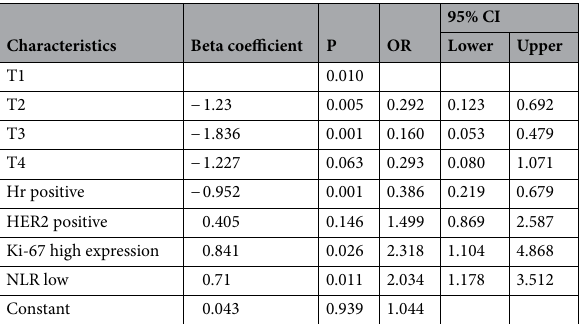
Table 3. The results of multivariate logistic regression analysis. HR hormone receptor, HER2 human epidermal growth factor receptor 2, NLR neutrophil–lymphocyte ratio.